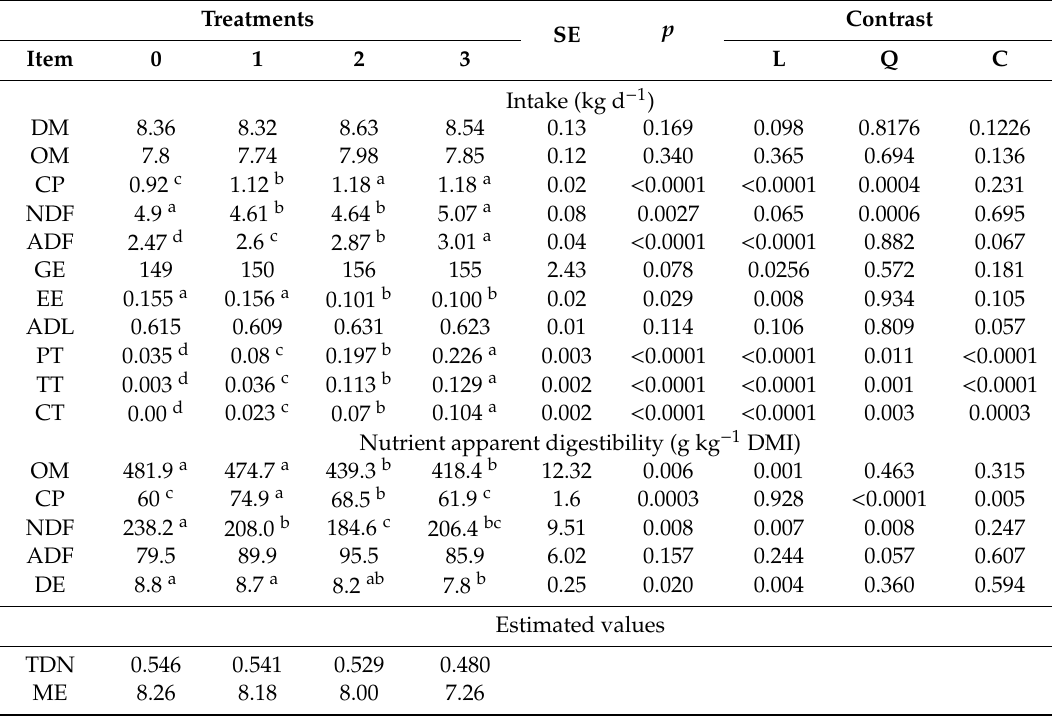
Table 4. E ff ect of dried L. leucocephala leaves supplementation on intake and apparent digestibility in heifers.